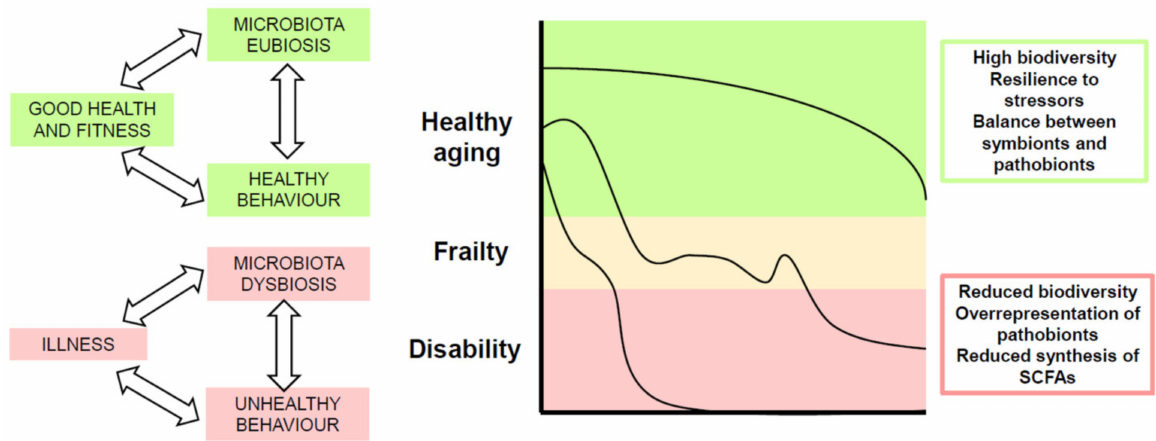
Figure 1. Hypothetical model of the possible association between microbiota and trajectories of aging, based on the current state of knowledge on the association between frailty and microbiota. Healthy aging (curve on the top of the graph) may be associated with maintenance of microbiota eubiosis (i.e., balance between symbionts and pathobionts) that contributes to the overall fitness of the organism in a virtuous cycle. Aging with frailty, characterized by a general, slow decline of health status and performance following acute illness and exacerbations of chronic diseases with occasional and transitory improvements (curve in the middle), may be associated with tendency towards microbiota dysbiosis (i.e., reduced species richness and increased representation of opportunistic pathogens). Disability, following an acute disruptive event or accelerated multimorbidity (curve on the bottom of the graph), may be associated with severe microbiota dysbiosis, leading to a vicious cycle that sustains illness and further decline of health